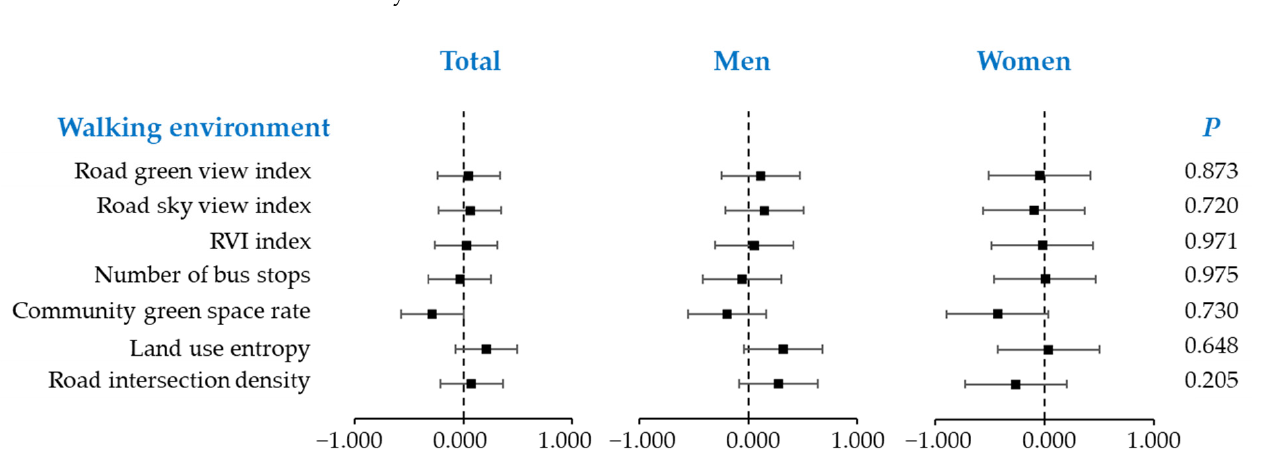
The heterogeneity of the walking environment exposed by the participants of different genders are listed in Figure 3. The results showed that even though men and women experience a certain degree of differences in walking environment, there is no significant heterogeneity between them. This is consistent with our guess; men and women are usually randomly distributed in distinct communities.